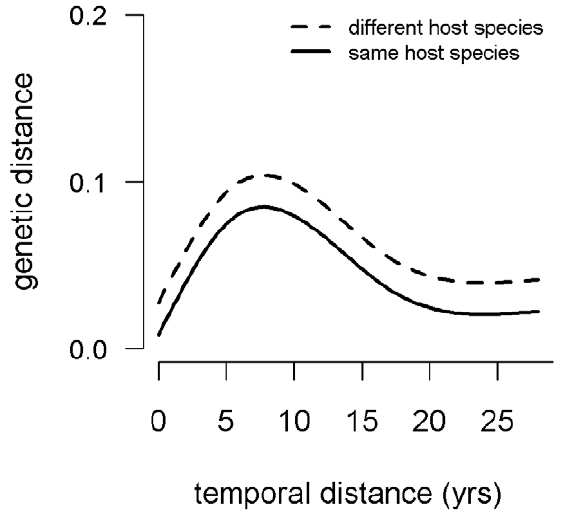
Figure 5. Genetic distance as a function of temporal distance and host species similarity. Isolates of Bacillus anthracis collected from the ENP during the period 1983–2010 are included.